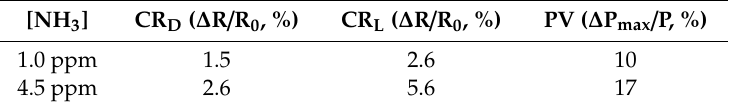
Table 1. Response of the SWCNT layer in the chemiresistive (CR D (dark conditions) and CR L (under ambient light)) and PV read-out configurations.